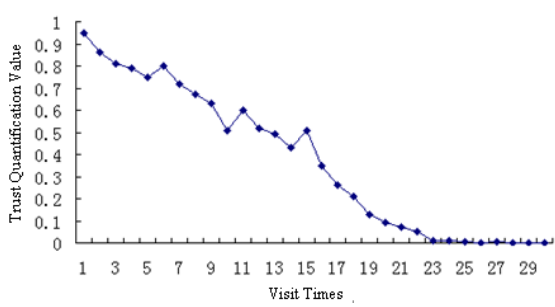
Fig. 6. Change of the trust quantification value for the hostile